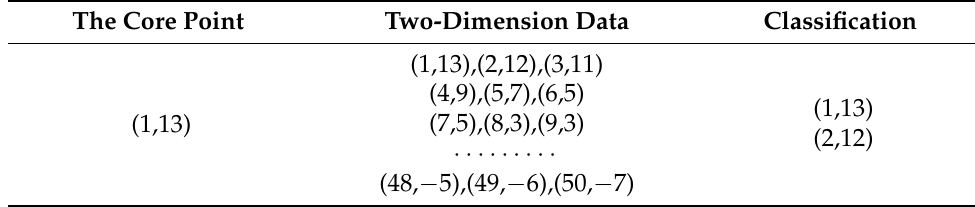
Table 3. The output of the real CNN model is selected by Algorithm